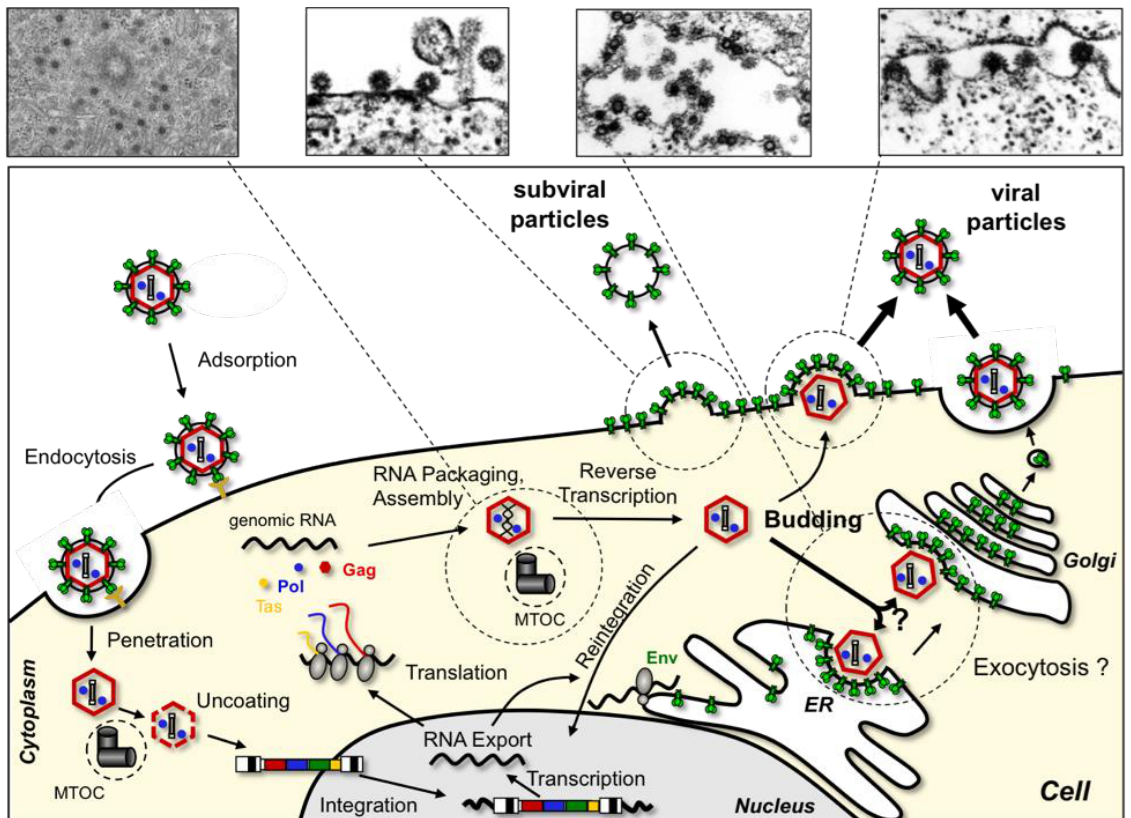
Figure 1. Schematic overview of the spuma- or foamy viruses (FV) replication cycle. Electron micrographs (courtesy of H. Zentgraf and J. Krijnse-Locker, Heidelberg) of different steps of FV particle morphogenesis are shown in the upper